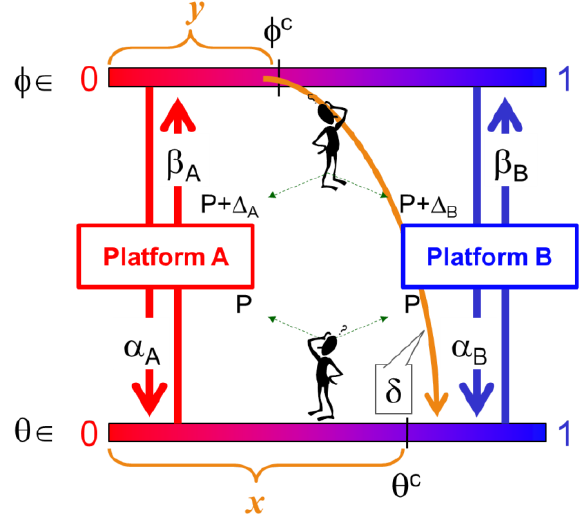
Figure 1. Dominant platform provider running two competing platforms (A and B).